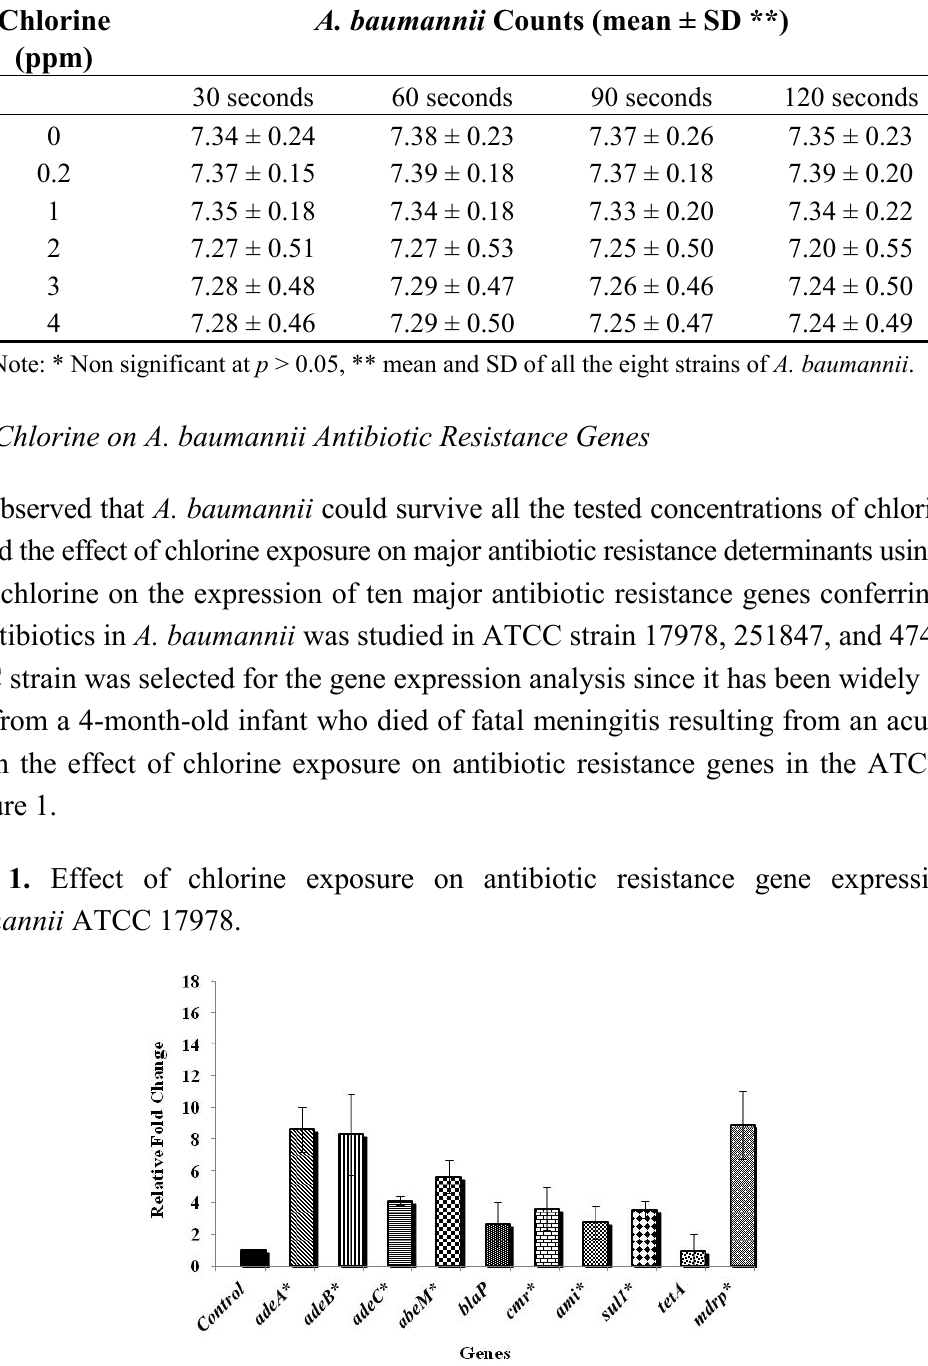
Note: * Genes significantly different from the control at p <